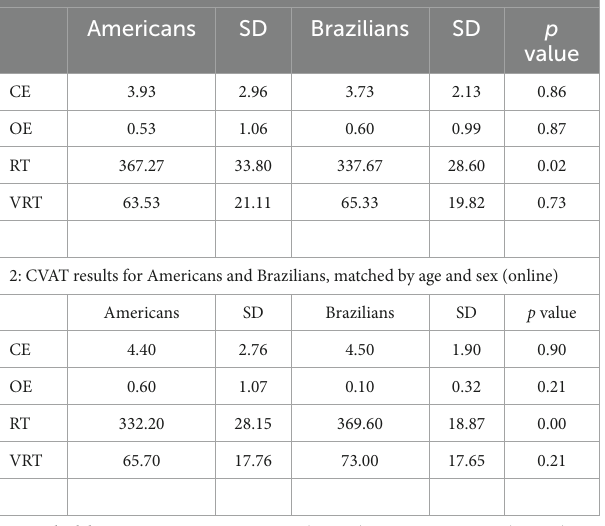
TABLE 7 Mean comparisons between Americans and Brazilians, matched by age and sex, and grouped by test modality (face-to-face vs. online). 1: CVAT results for Americans and Brazilians, matched by age and sex (face-to-face). Americans SD